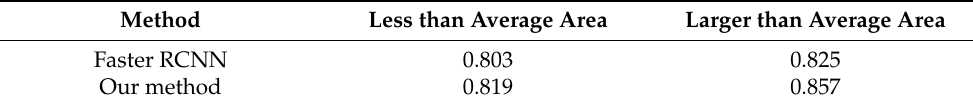
Table 3. IoU of the Two Experiments Classified by Area of Construction Projects.